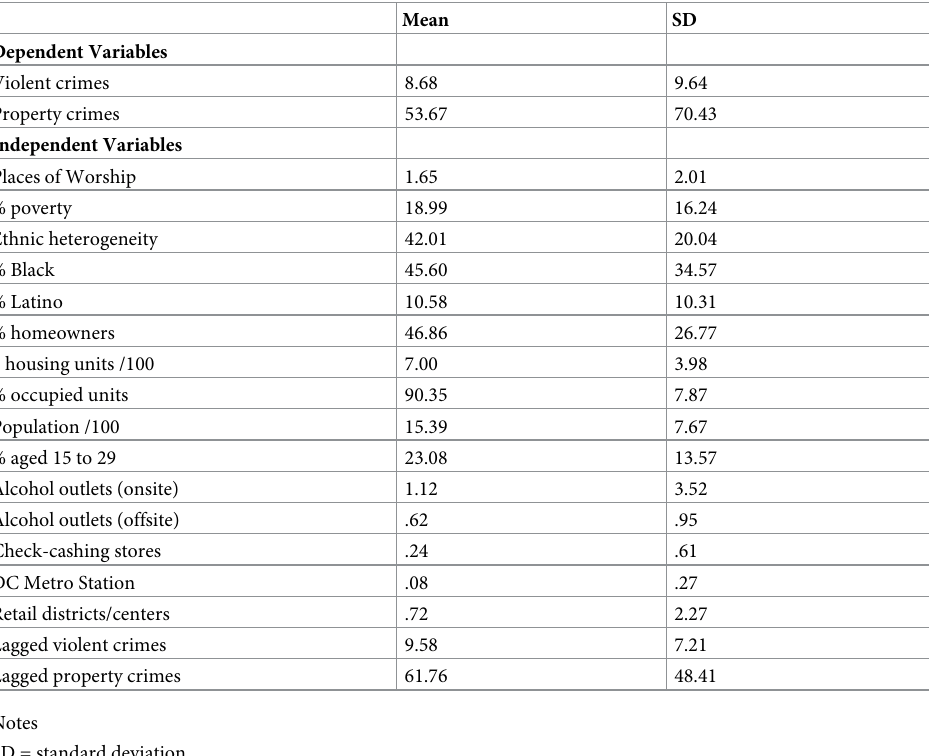
Table 1. Summary